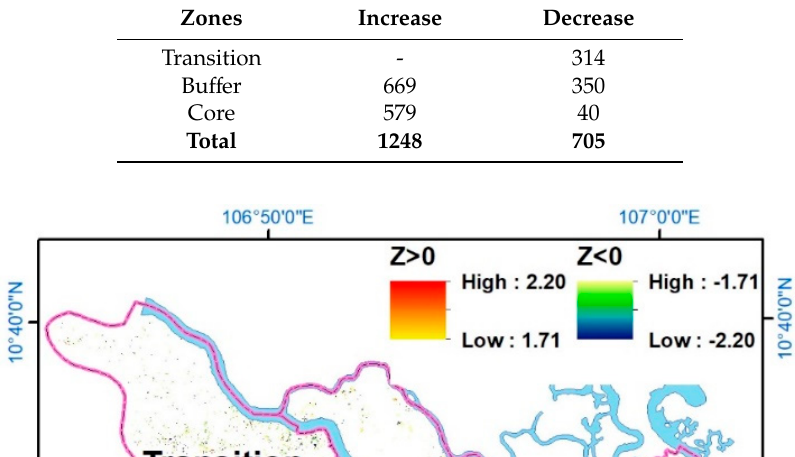
Table 6. The significant changes in mangrove area through three ecological zones from 2015 to 2019 (ha).